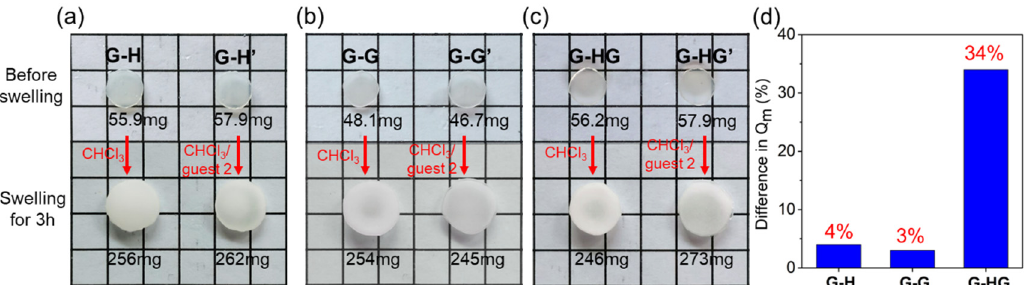
Figure 5. Photographs of polymer gels of ( a ) G-H and G-H’ , ( b ) G-G and G-G’ , and ( c ) G-HG and G-HG’ before and after soaking in CHCl 3 or 25 mM CHCl 3 / guest 2 solution, respectively. The circular sheet samples of gels immersed in CHCl 3 were called G-H , G-G , and G-HG , whereas those soaked in 25 mM guest 2 /CHCl 3 solution were labeled G-H’ , G-G’ , and G-HG’ , respectively. The square of figure is 1 cm × 1 cm. ( d ) The difference in the mass swelling ratio of the two samples of G-H , G-G, and G-HG gels.